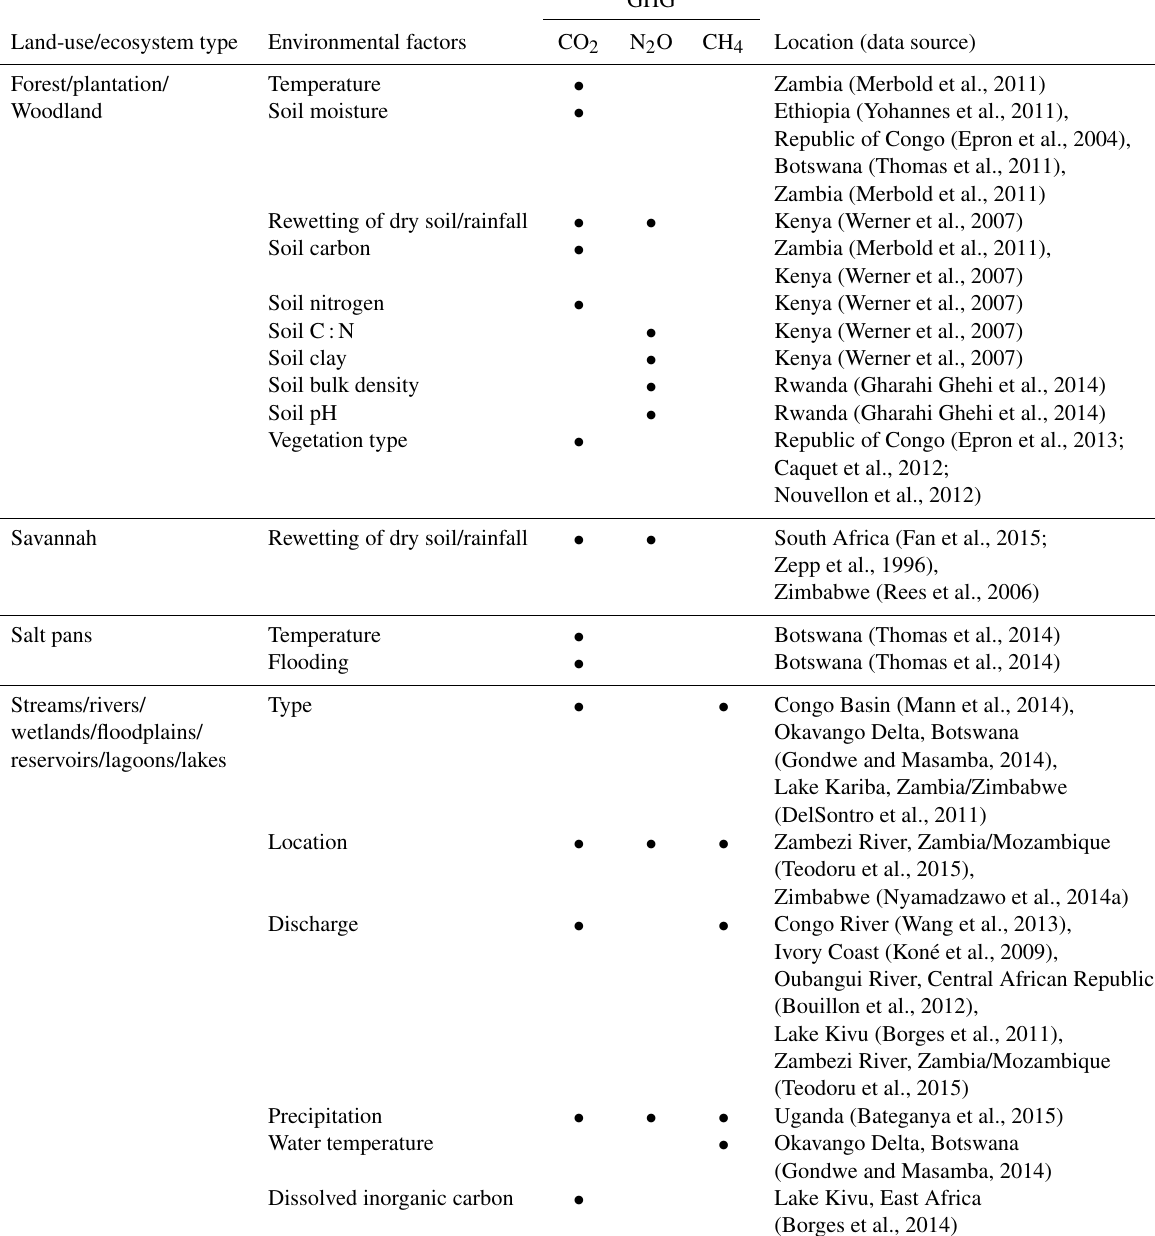
Table 3. Summary of environmental factors affecting greenhouse gas (GHG) emissions in land-use/ecosystem type. ◦ indicates GHG affected by environmental factor